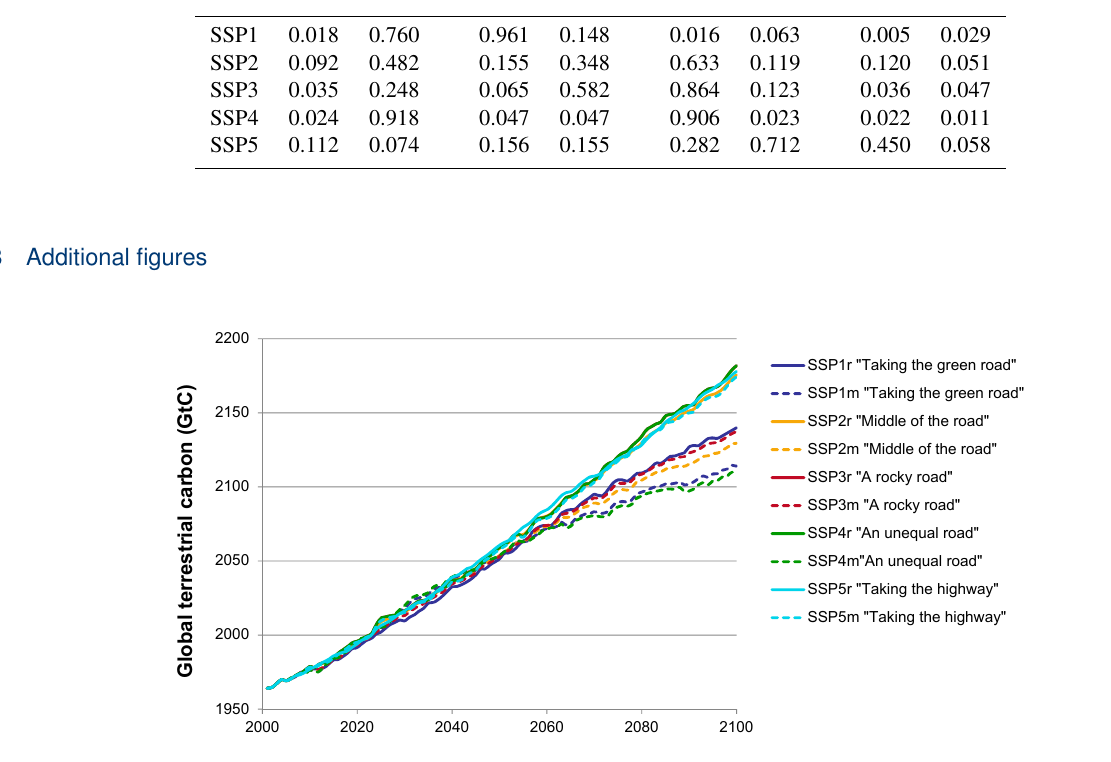
Figure A1. Global terrestrial biosphere carbon (GtC) simulated with constant year 2000 land cover forced by climate change fields from the IPSL GCM. Scenarios with large shares of RCP8.5 and RCP6.0 (SSP2r, SSP3r, SSP4r, SSP5r and SSP5m) achieve highest global terrestrial carbon in 2100, scenario mainly driven by mainly RCP2.6 (SSP1m and SSP4) result in the lowest global terrestrial carbon, while scenarios mainly driven by RCP4.5 (SSP1r, SSP2m and SSP3m) place in between.